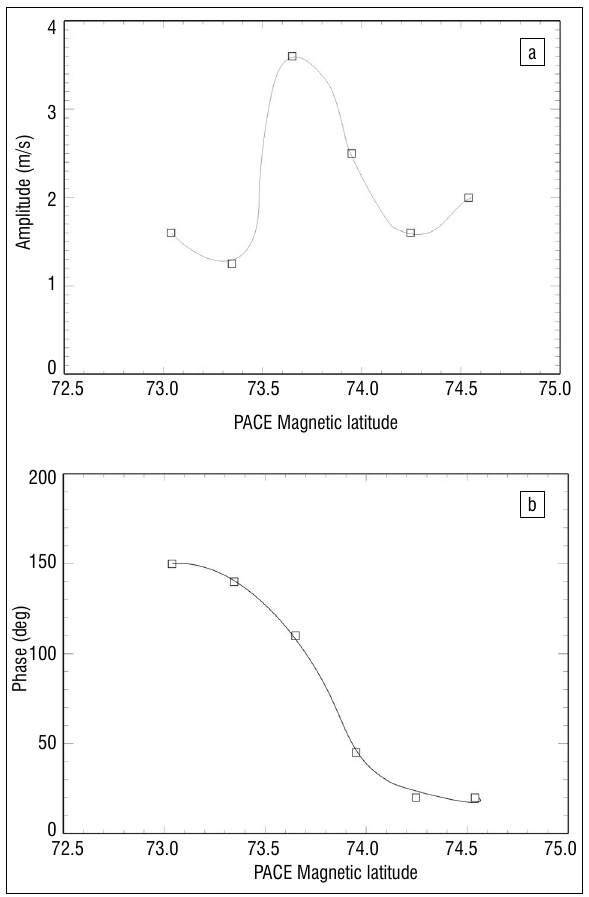
Figure 4: Doppler velocities of the Goose Bay radar of the given beams and range